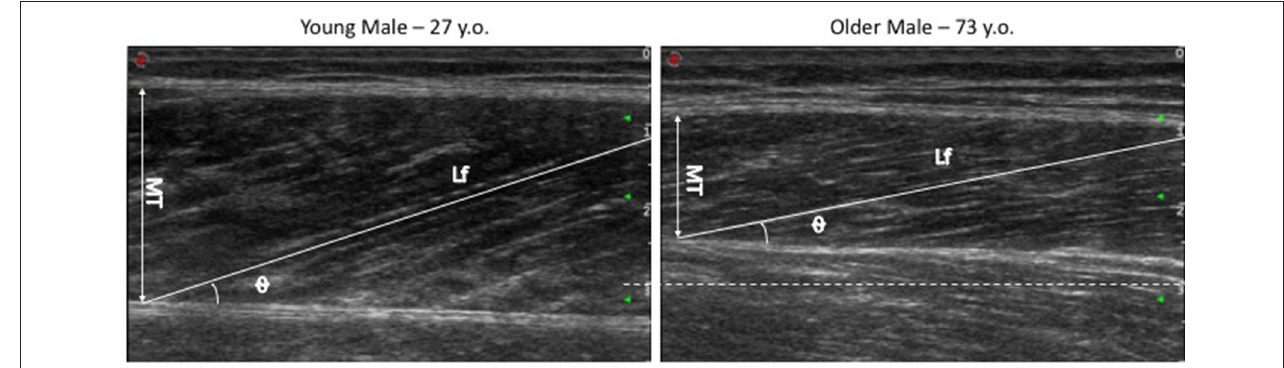
FIGURE 2 | Vastus lateralis US images of Young vs. Old volunteers (acquired with same scale and US preset parameters). The dotted white line represents the 3cm scale value, highlighting that images share the same starting point (0cm) and that the representative image from the old volunteer shows a significantly smaller MT compared to the young